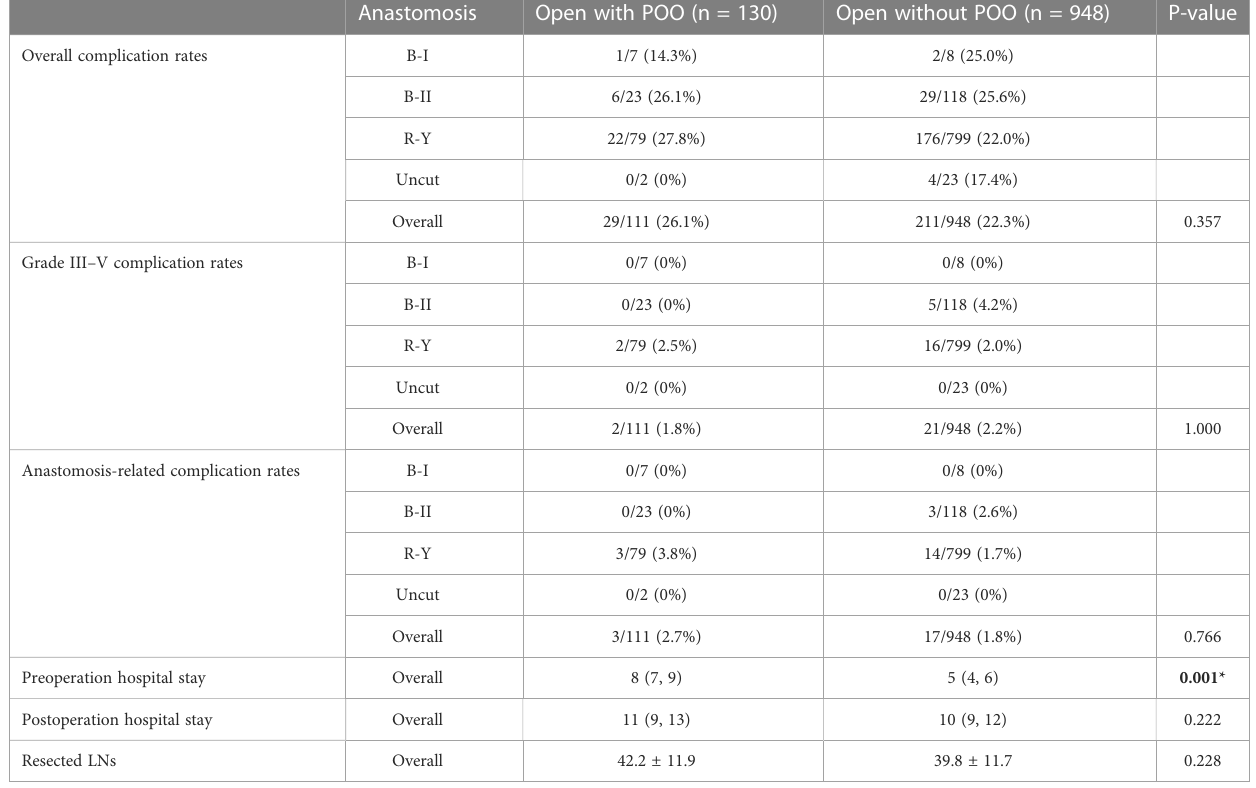
TABLE 3 The information of complication rates, hospital stays and resected LNs between POO and non-POO patients of open cases from NMUH.